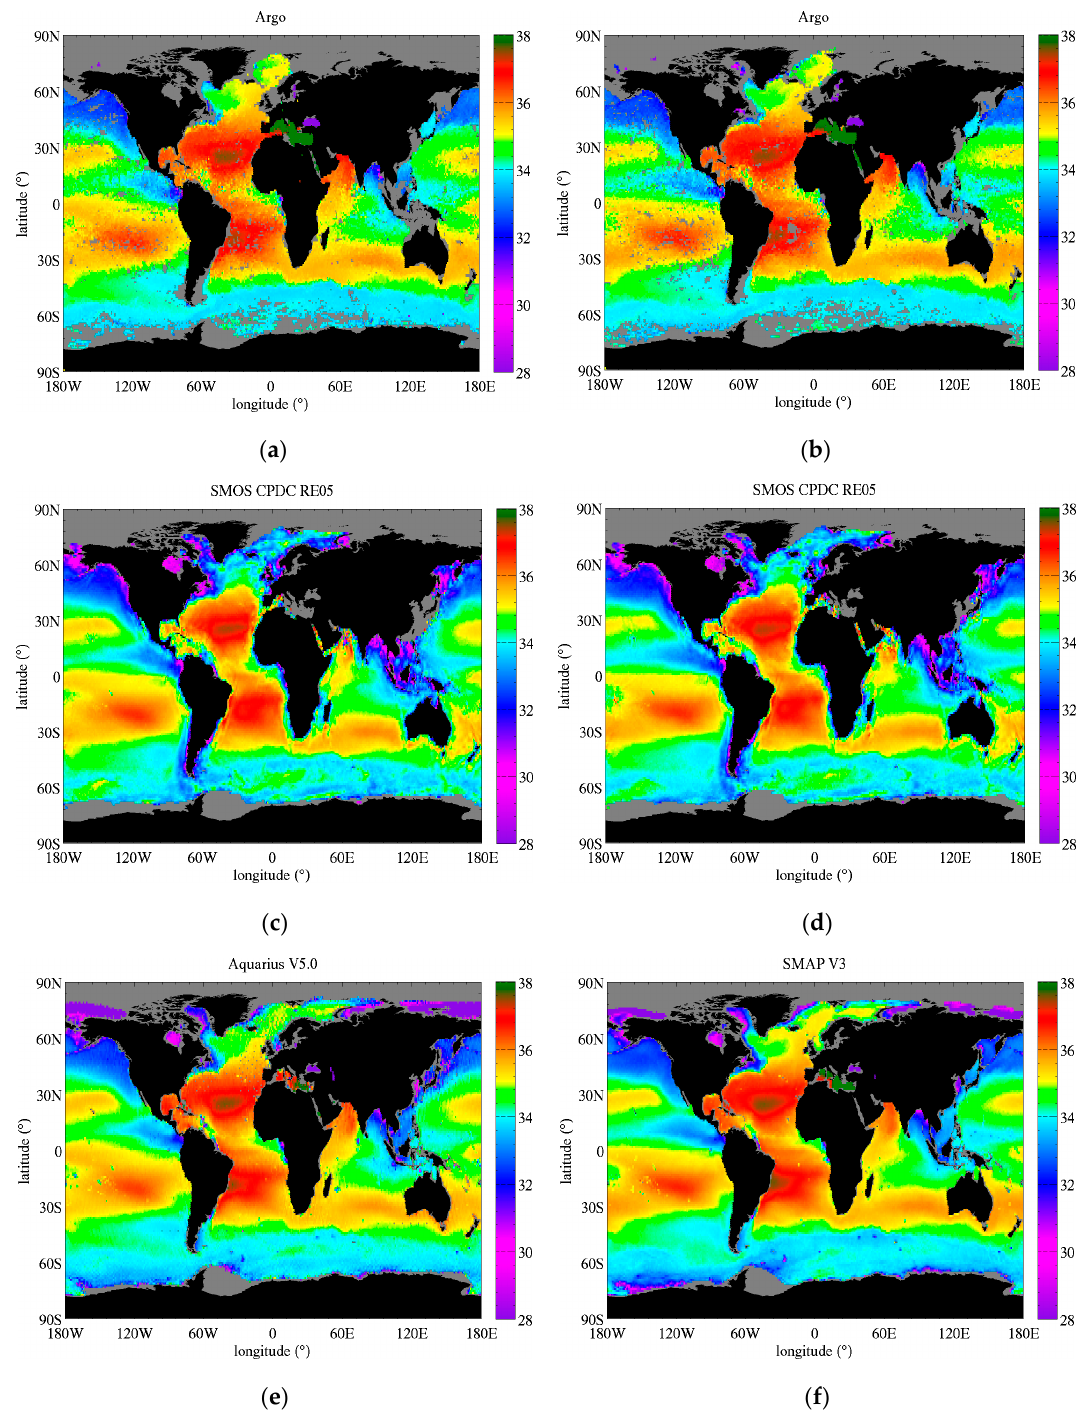
Figure 8. Global map of SSS from satellite sensors and in situ measurements averaged over several years. On the left: ( a ) Argo SSS, ( c ) SMOS SSS, and ( e ) Aquarius SSS are averaged over the Aquarius era (i.e., Sept 2011–May 2015). On the right: ( b ) Argo SSS, ( d ) SMOS SSS, and ( f ) SMAP SSS are averaged over the period April 2015–June 2018. Grey color reports missing data.